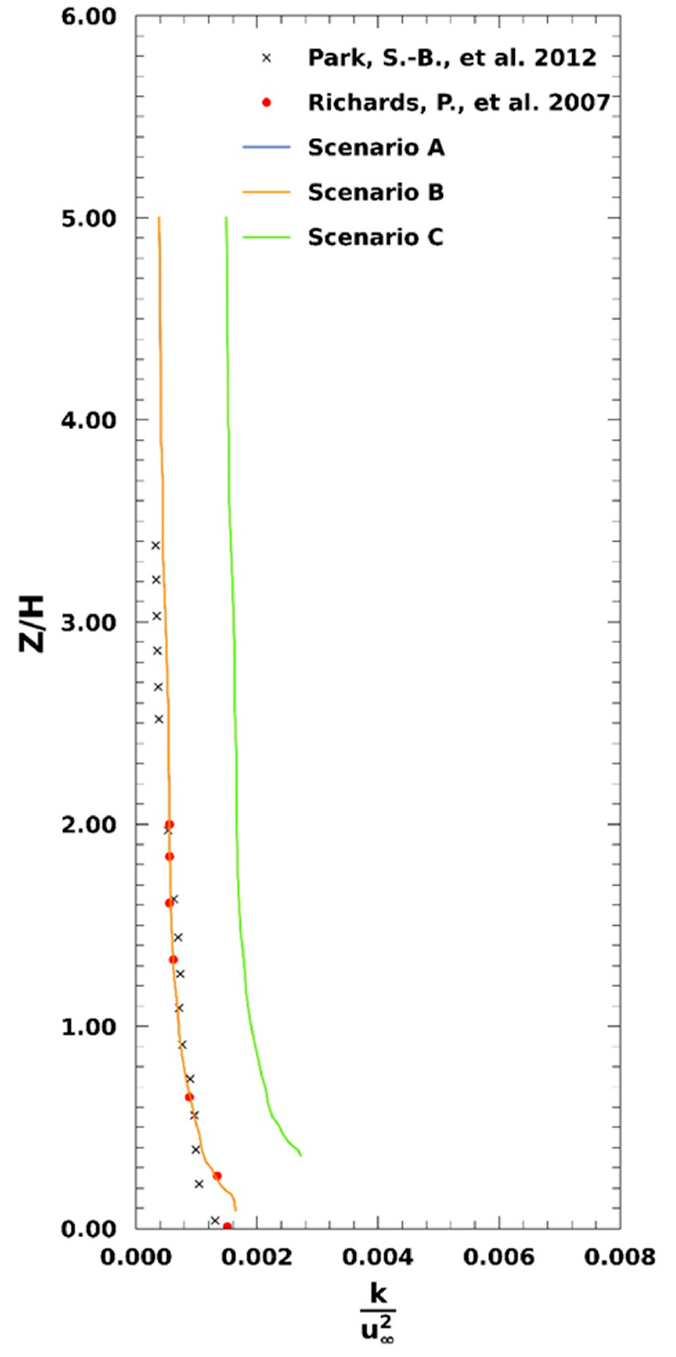
Figure 4. Turbulent kinetic energy at the inlet of the computational domain for Scenarios A–C [18,44]. On the lateral boundaries of the computational domain, periodic boundary condi- tions are employed because of the temporal and spatial periodicity of the flow. Neu- mann boundary conditions are used for the turbulent kinetic energy ( e ) , temperature ( θ ) , and the perturbation pressure ( p ∗ ) to calculate the following equations concerning the building’s